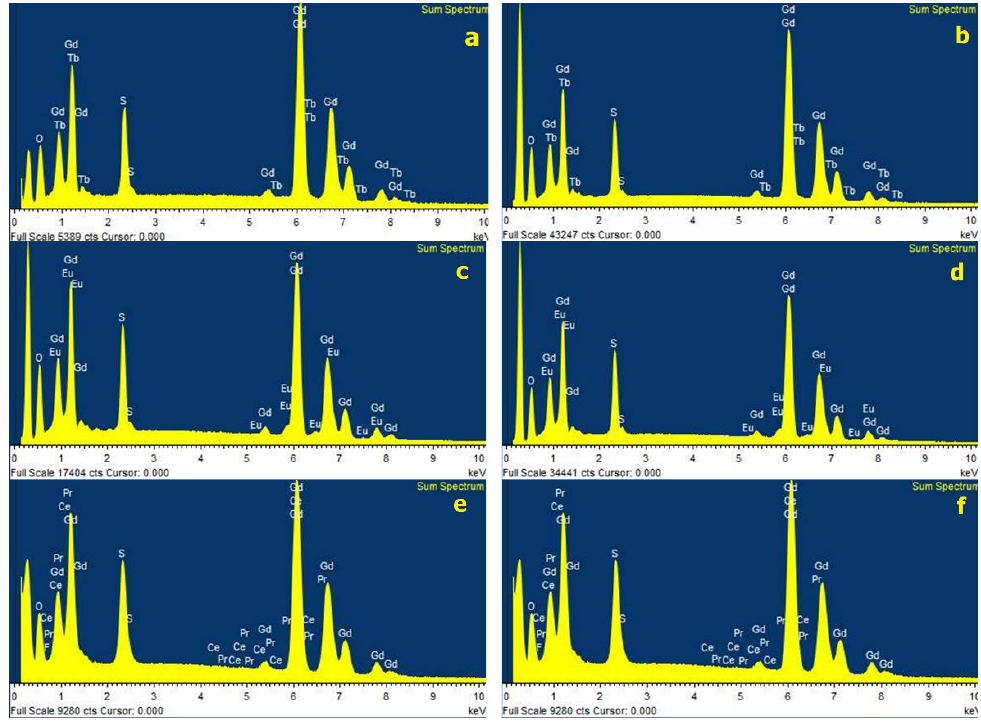
Figure 2. EDX spectra: ( a ) Gd 2 O 2 S:Tb UKL65/UF-R1, ( b ) Gd 2 O 2 S:Tb UKL65/F-R1, ( c ) Gd 2 O 2 S:Eu UKL63/UF-R1, ( d ) Gd 2 O 2 S:Eu UKL63/N-R1, ( e ) Gd 2 O 2 S:Pr,Ce,F UKL59CF/F-R1, and ( f ) Gd 2 O 2 S:Pr,Ce,F UKL59CF/S-R1